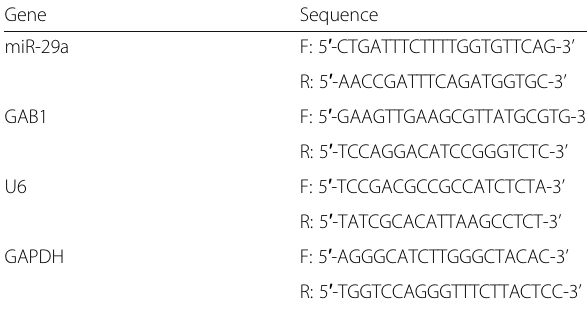
Table 1 Primer sequences of RT-qPCR